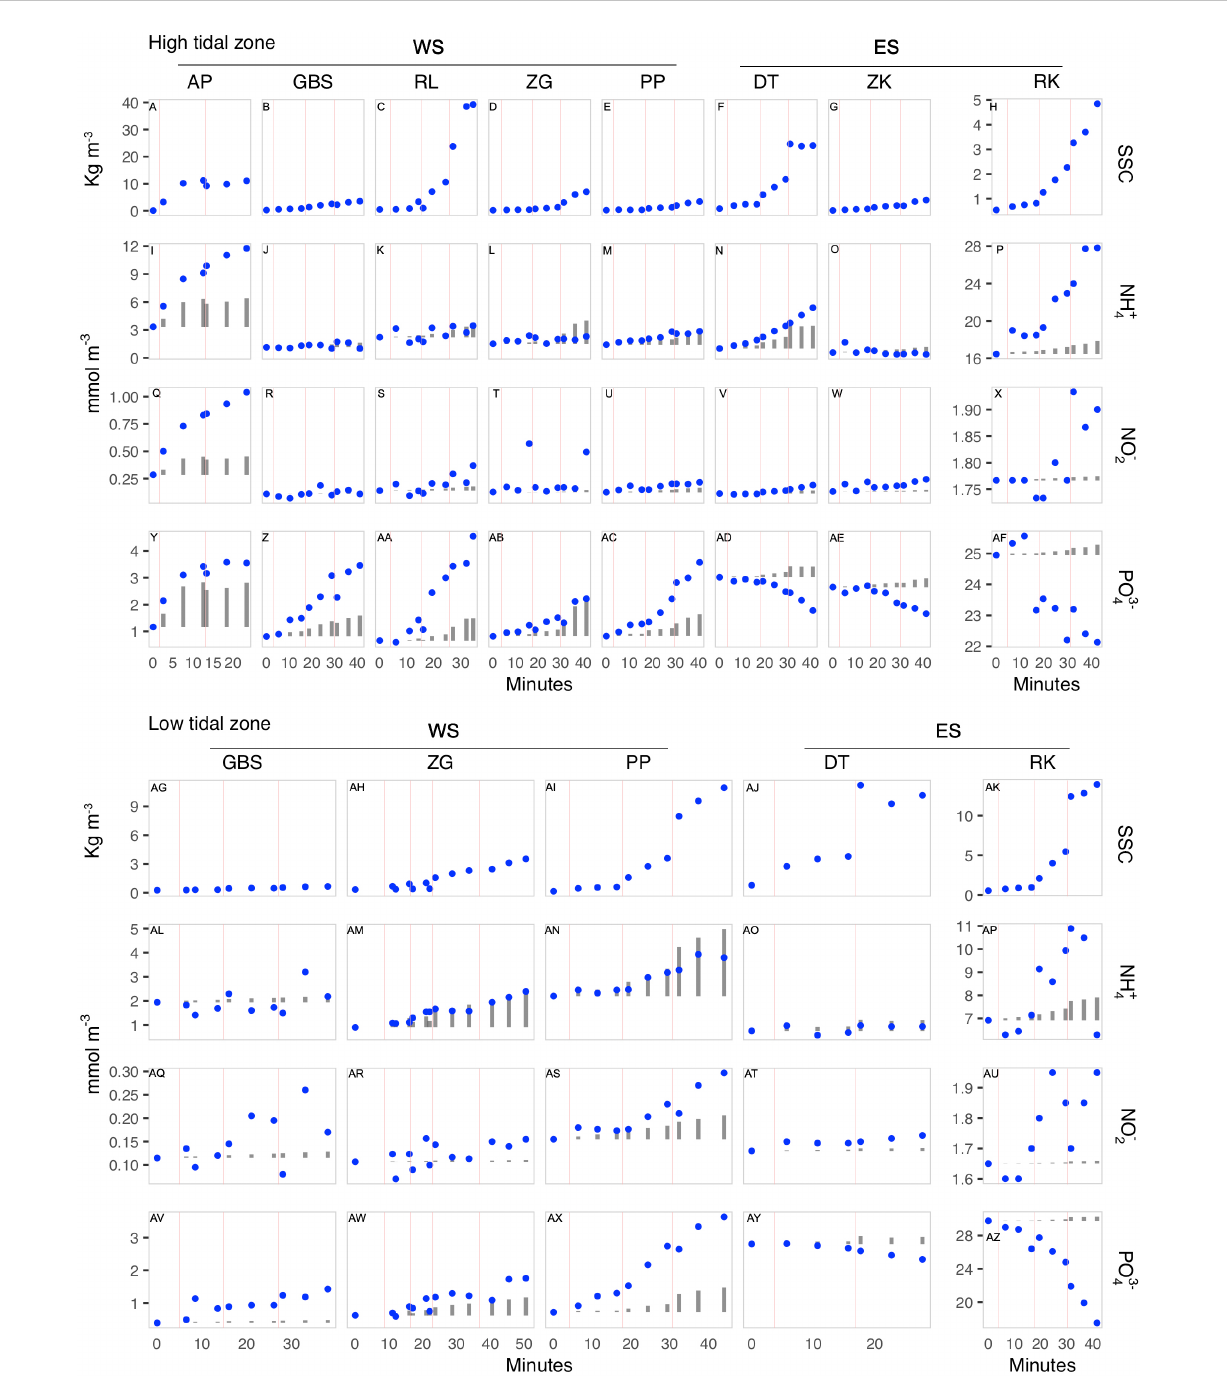
FIGURE 4 Nutrient release and suspended sediment concentration (SSC) changes due to sediment erosion over time in the high (A – AF) and low (AG – AZ) tidal zone locations of the Eastern (ES) and Western Scheldt (WS). All nutrient concentrations expressed in mmol m-3. Suspended sediments concentration in Kg m-3. Blue dots denote measured nutrient concentrations during the erosion experiment. Grey bars indicate the bottom water concentration at the beginning of the experiment (t0) plus the predicted increase in concentration solely from dilution of pore water nutrients from the eroded layer of top sediments, as calculated from the suspended particles concentration. Red lines indicate the moments at which the speed was increased during the experiment. Western Scheldt sites AP, GBS, RL, ZG, and PP are ordered from upstream to downstream